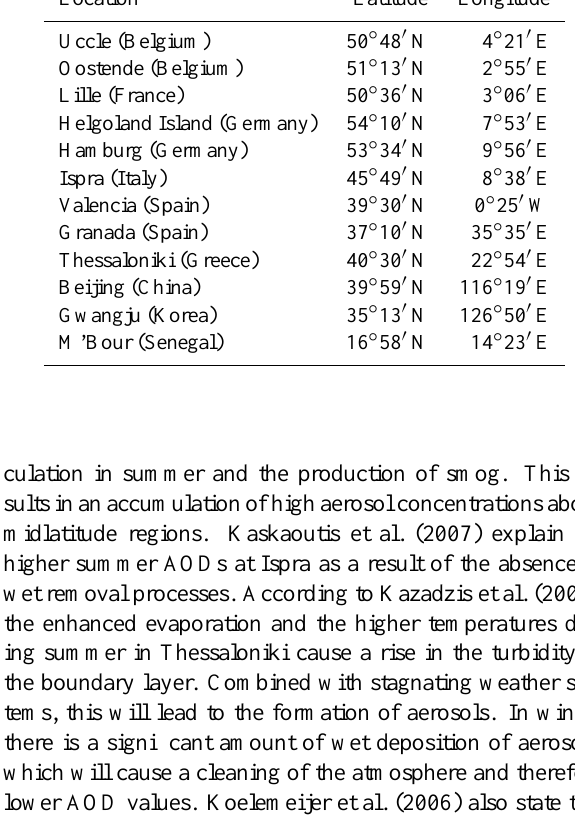
Fig. 6. Seasonal frequency distribution of AOD values at 340nm at